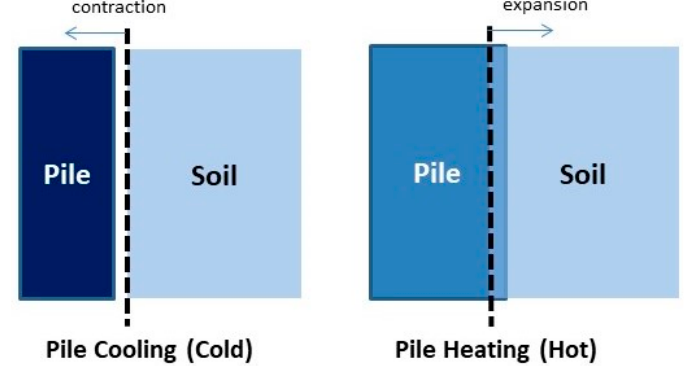
Figure 1. Potential heat-expansion and cool-contraction of the pile.